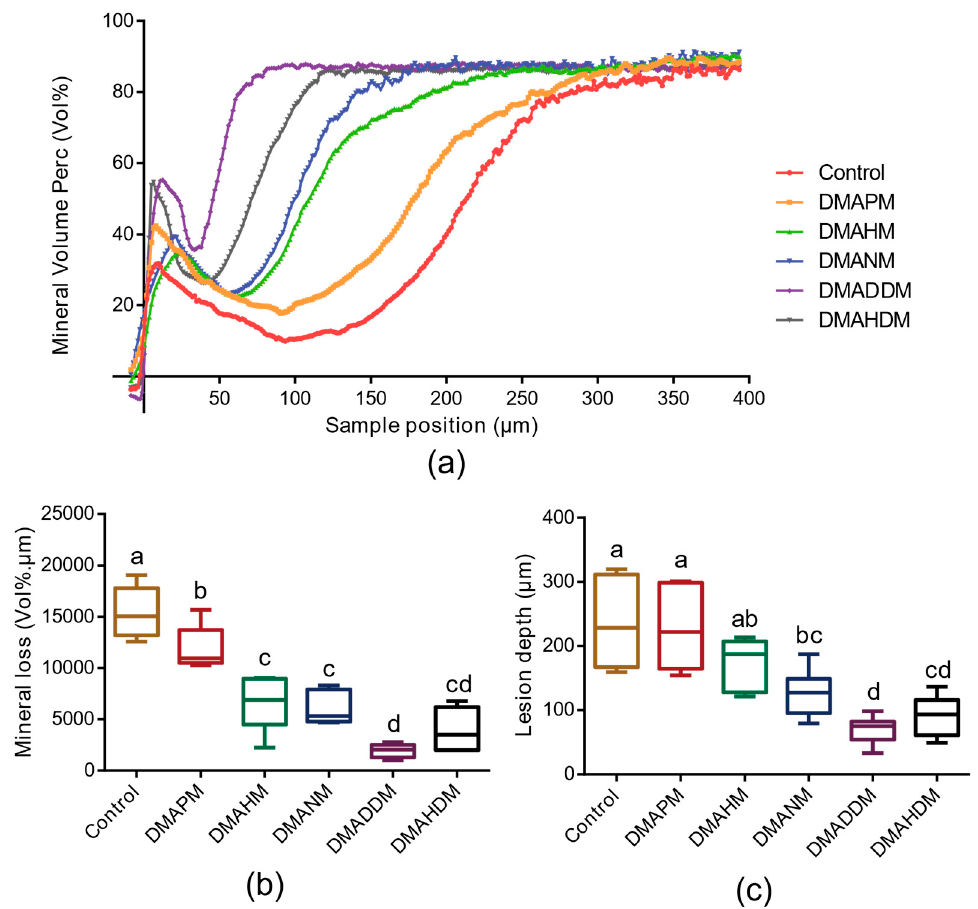
Figure 7. The enamel demineralization tested by transverse microradiography (TMR). ( a ) Mineral volume content of the enamel bonding with composites by QAM adhesives; ( b ) mineral loss ( n = 6); and ( c ) lesion depth ( n = 6) of enamel bonding with composites by adhesives containing QAMs with different alkyl chain lengths (CL = 3, 6, 9, 12, and 16) or none. Bars with the same letter indicate a value having no significant distance, and those with different letters indicate a significant difference ( p < 0.05).